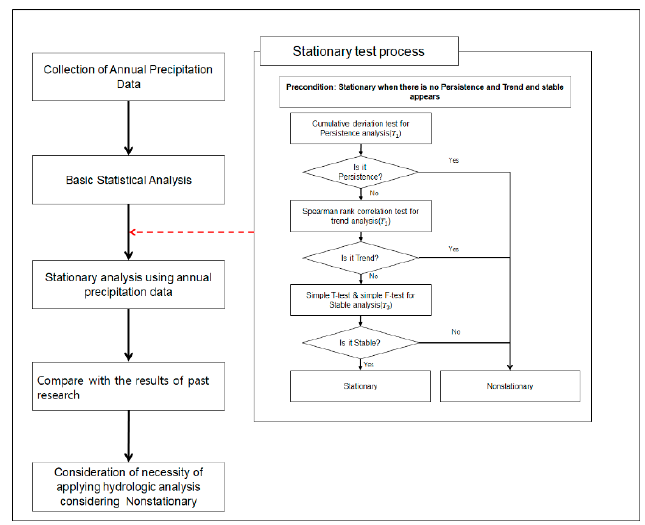
Figure 1. Flow chart of Stationary test.